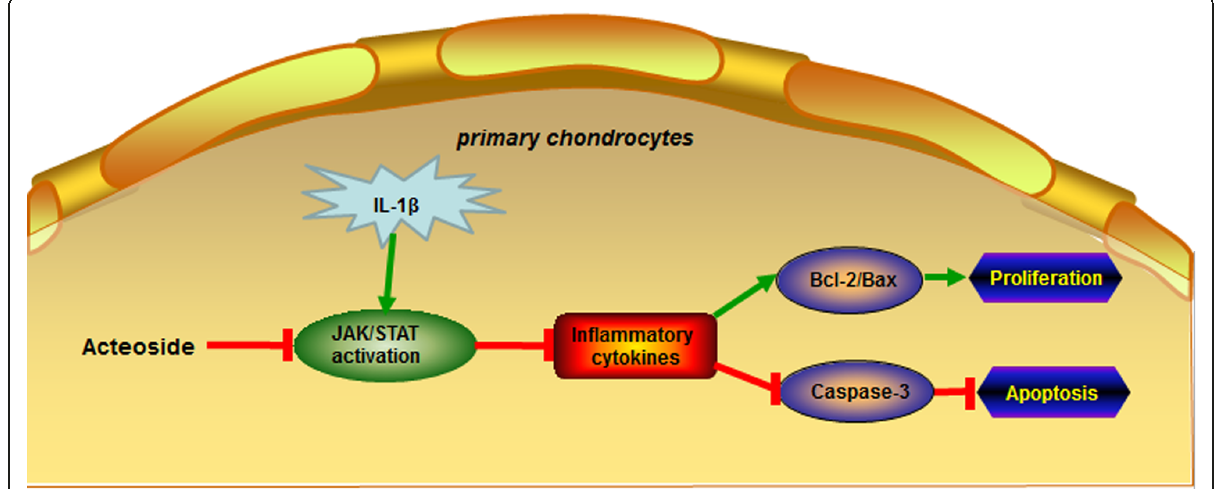
Fig. 7 The diagram of mechanisms how acteoside inhibits inflammatory response via JAK/STAT signaling pathway in primary